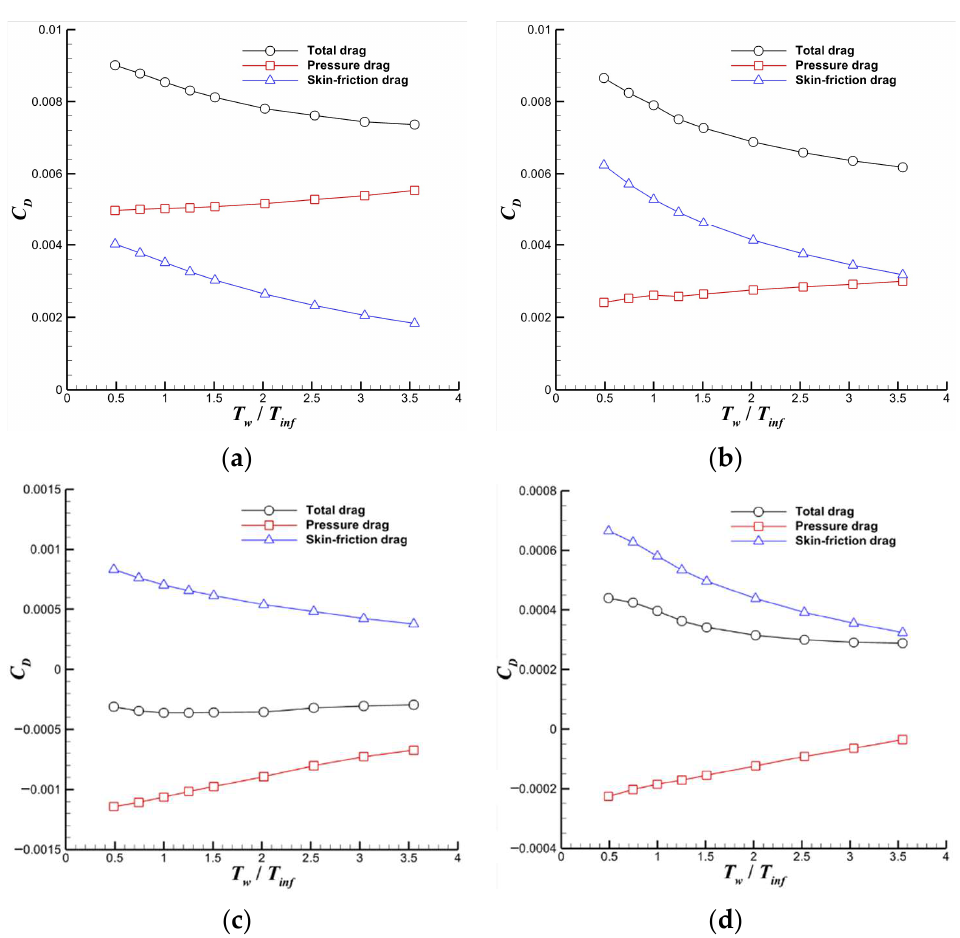
Figure 9. Effect of wall-temperature gradient on pressure drag and skin-friction drag. ( a ) Wing; ( b ) fuselage; ( c ) horizontal tail; ( d ) vertical tail. ( b ) fuselage; ( c ) horizontal tail; ( d ) vertical